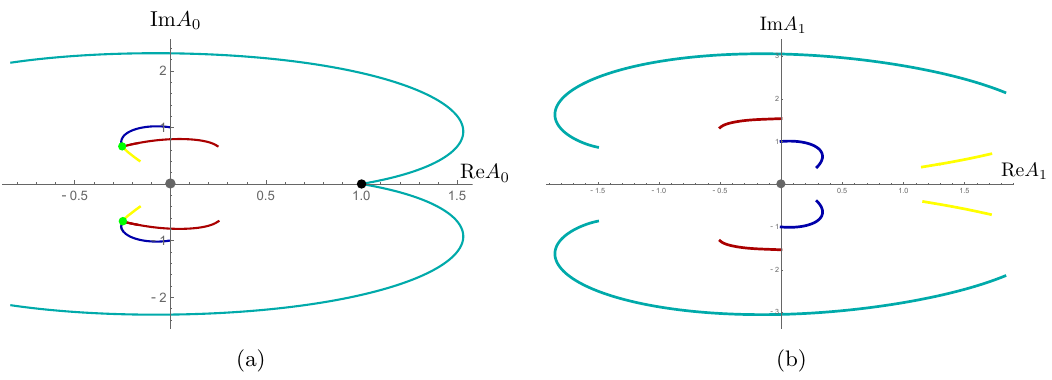
Figure 9 . Trajectories of saddle points parametrized by µ on the complex plane. The black point is the corresponding replica-symmetric solution with a 0 = A 0 . The green points are the complex replica-symmetric